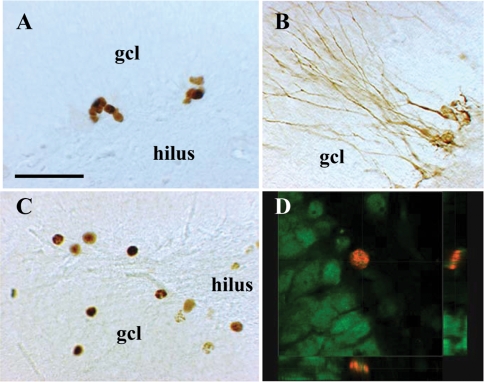
Illustration of neurogenesis in the dentate gyrus.Examples of : (A) Ki67-IR cells (B) DCX-IR cells and (C) 3-week-old BrdU-IR cells. (D) Three dimensional reconstruction of a z series along the y-z axis (narrow right panel) and x-z axis (narrow bottom panel) showing that a 3-week-old newly born cell (red) is double stained with the neuronal marker NeuN (green). Scale bar : A–C, 50 µm. gcl = granule cell layer.